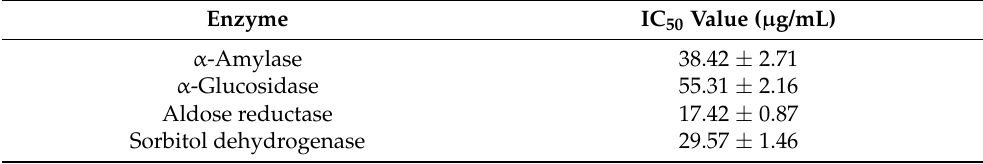
Table 7. In vitro enzyme-inhibitory properties of A. nilagirica expressed as IC 50 values ( µ